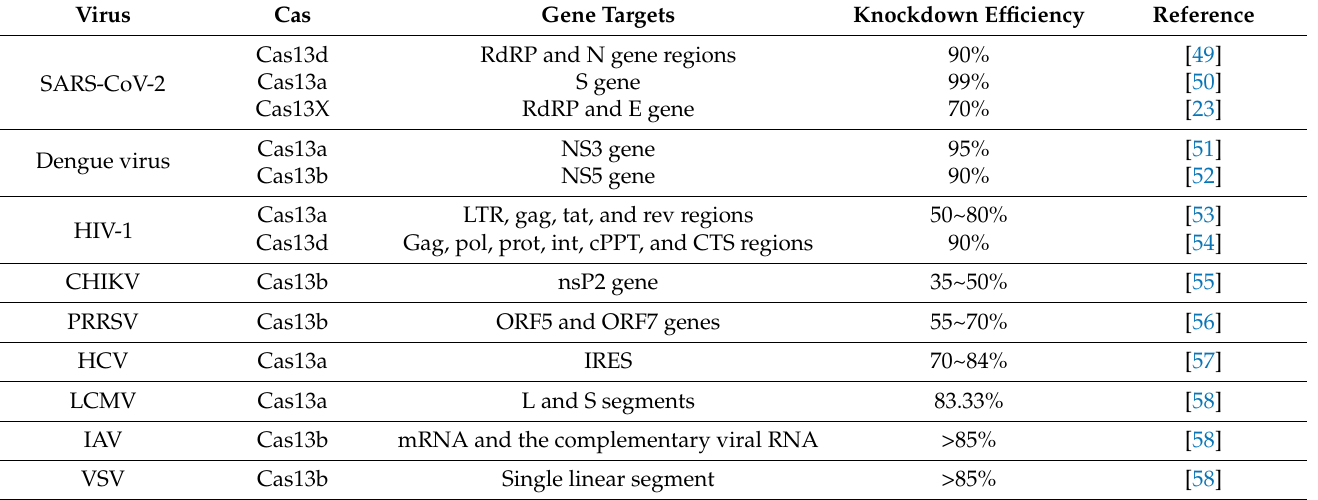
Table 2. CRISPR-Cas13-based RNA virus